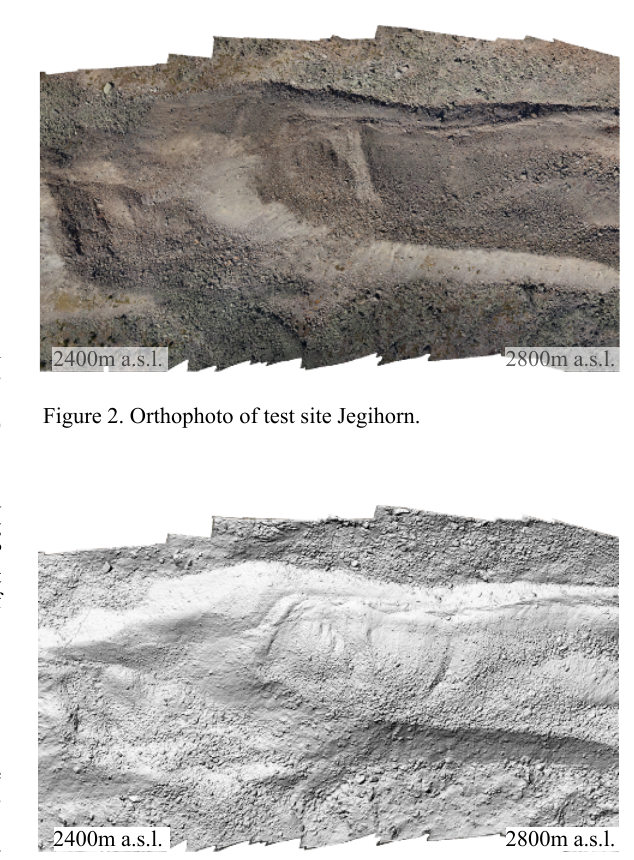
Figure 3. DSM of test site